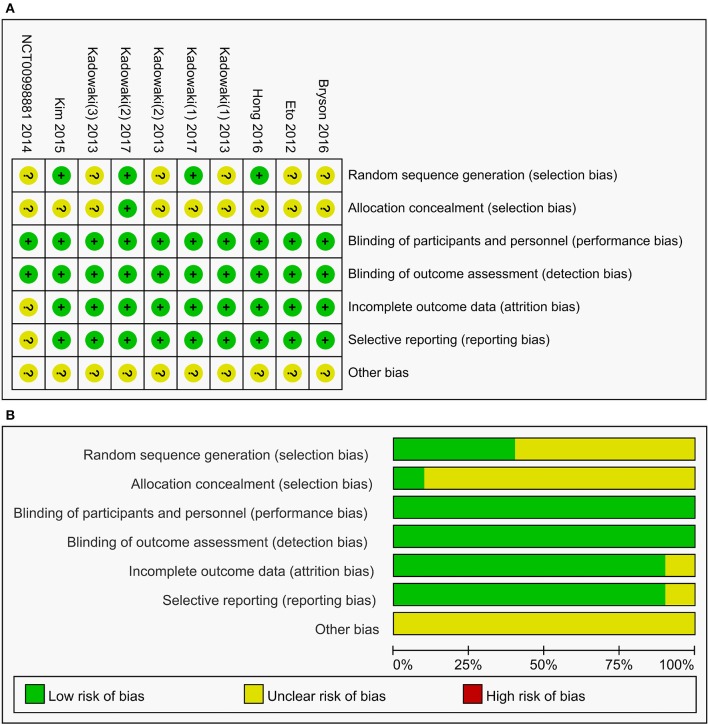
Summary (A) and graph (B) of the risk of bias in the included trials by Cochrane risk of bias toll based upon reviewers' judgment of each domain.